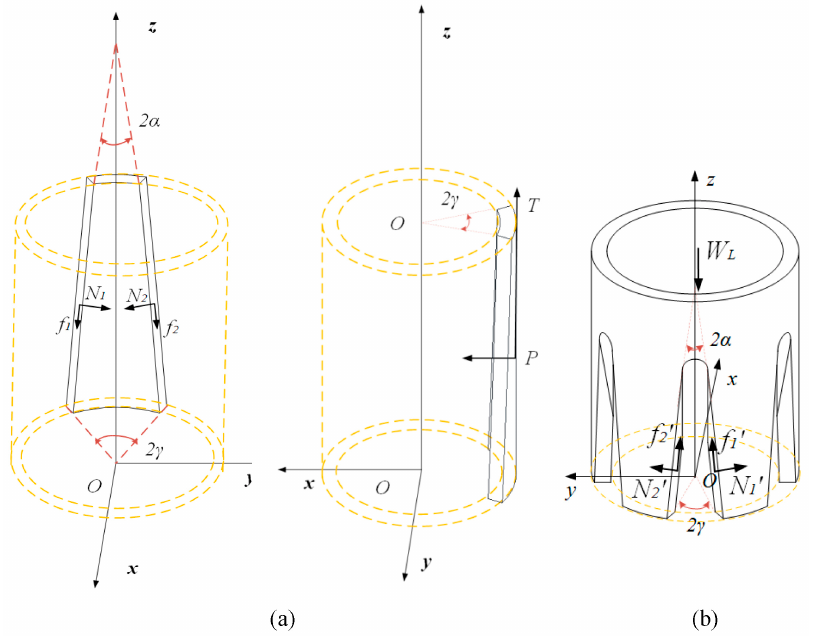
Figure 5. Mechanical model and main geometrical parameters of ( a ) slip and ( b ) slip-seat.